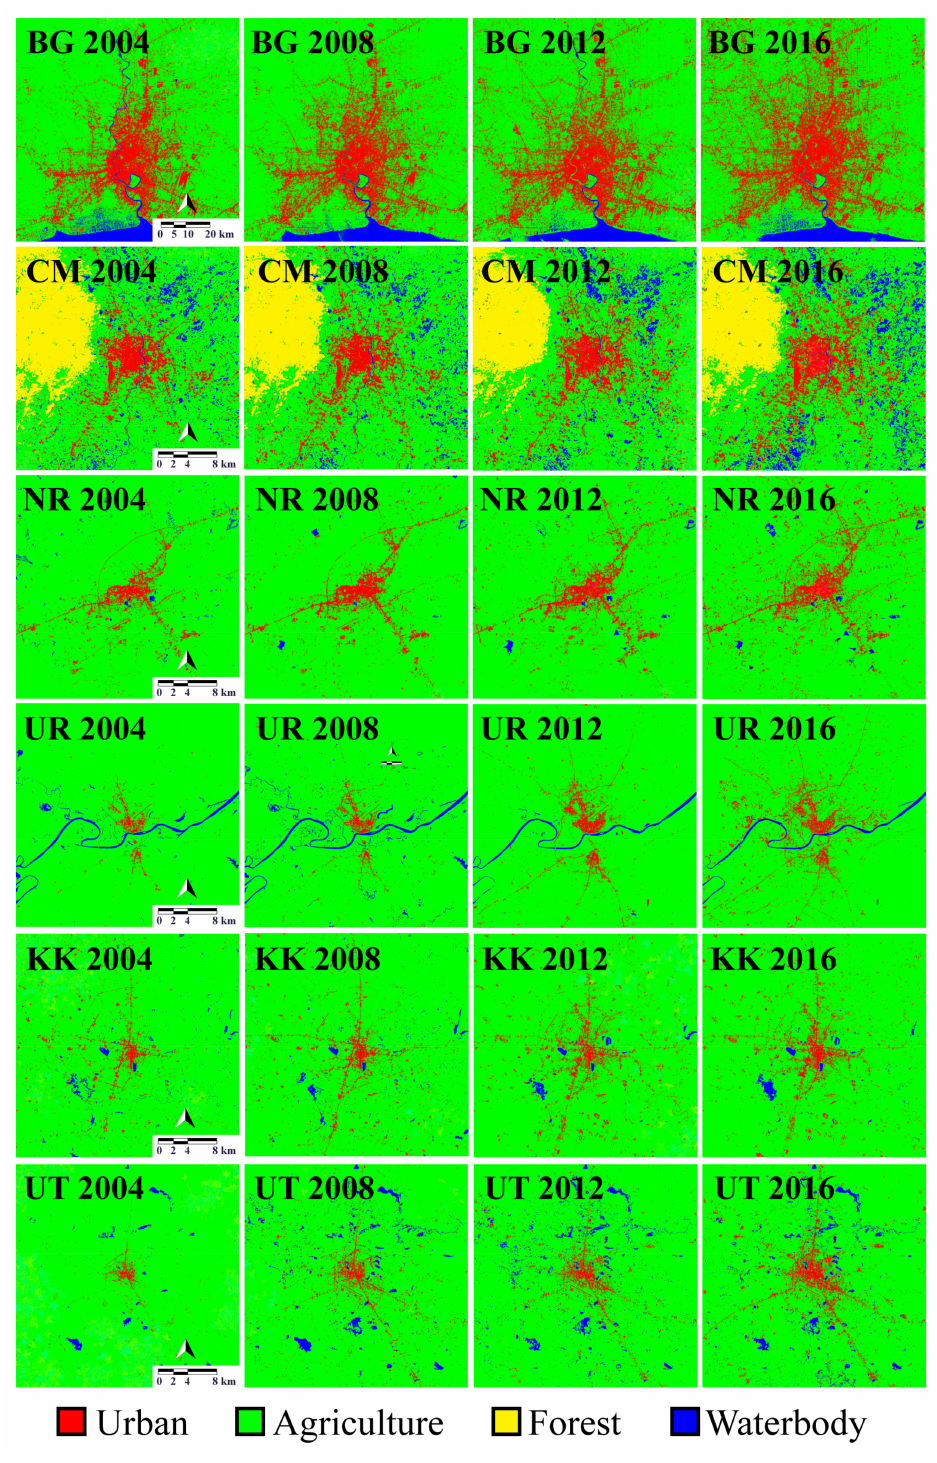
Figure 2. Maps of urban surface (red) evolution for the six cities in the years 2004, 2008, 2012, and 2016 obtained from Landsat data (see Section 3.1). From top: Bangkok (BG), Chiang Mai (CM), Nakhon Ratchasima (NR), Ubon Ratchathani (UR), Khon Kaen (KK), and Udon Thani (UT). All panels represent a 30 × 30 km area except for Bangkok, 90 × 90